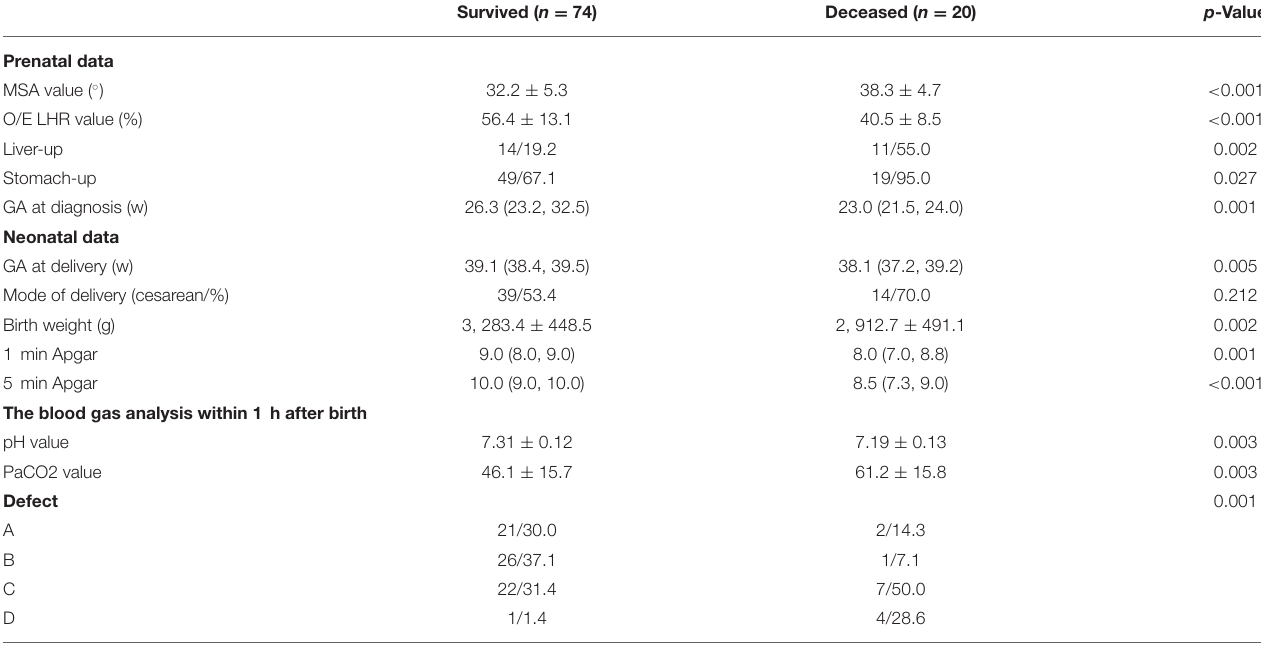
TABLE 1 | Pre- and postnatal clinical characteristics according to survival at discharge.